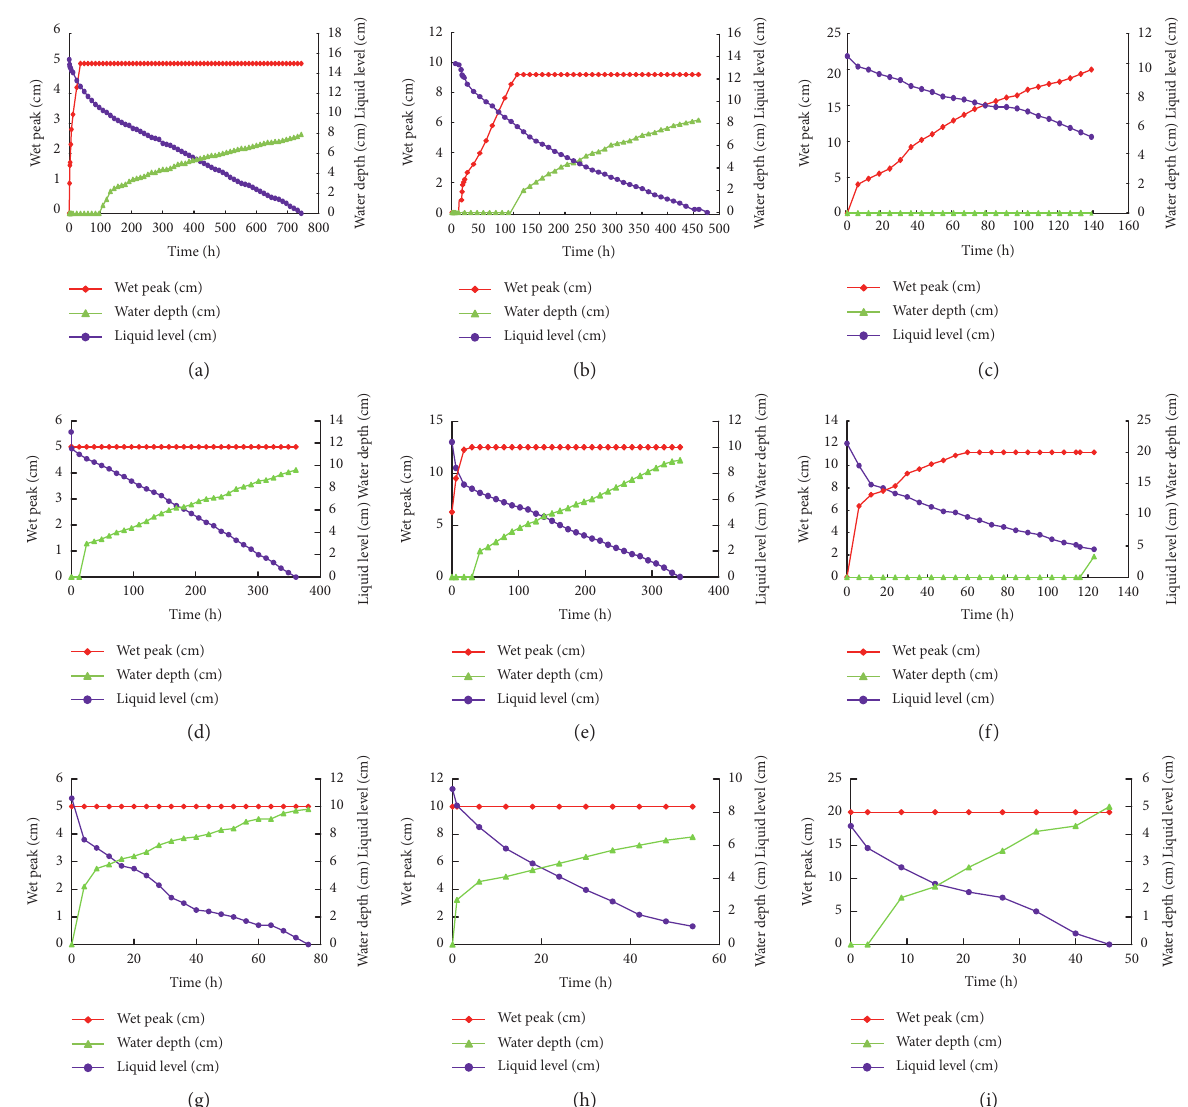
Figure 7: Curve of the relationship between wetting front, liquid level, water depth of beaker, and time: (a) 0.5mm/5cm seepage curve of soil column experiment. (b) 0.5mm/10cm seepage curve of soil column experiment. (c) 0.5mm/20cm seepage curve of soil column experiment. (d) 1mm/5cm seepage curve of soil column experiment. (e) 1mm/10cm seepage curve of soil column experiment. (f) 1mm/20cm seepage curve of soil column experiment. (g) 2mm/5cm seepage curve of soil column experiment. (h) 2mm/10cm seepage curve of soil column experiment. (i) 2mm/20cm seepage curve of soil column